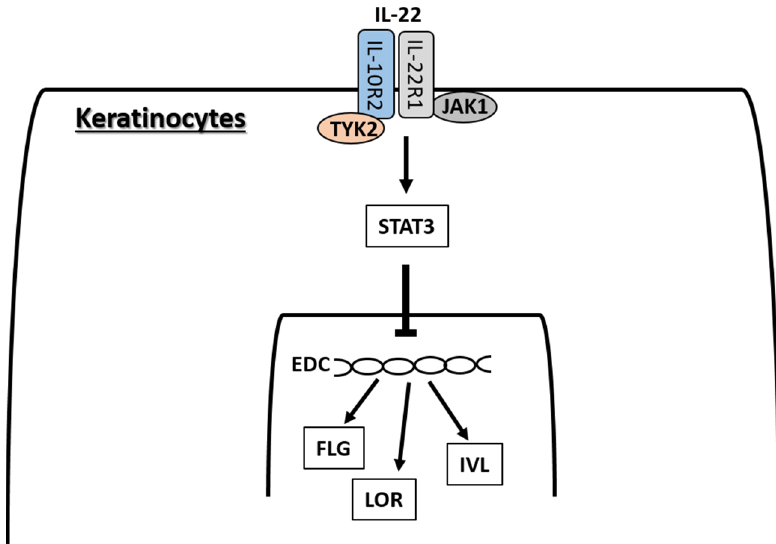
Figure 5. IL-22 binds IL-22R1/IL-10R2 complex, activates the JAK1/TYK2-STAT3 pathway and inhibits the expression of FLG, LOR, and IVL.